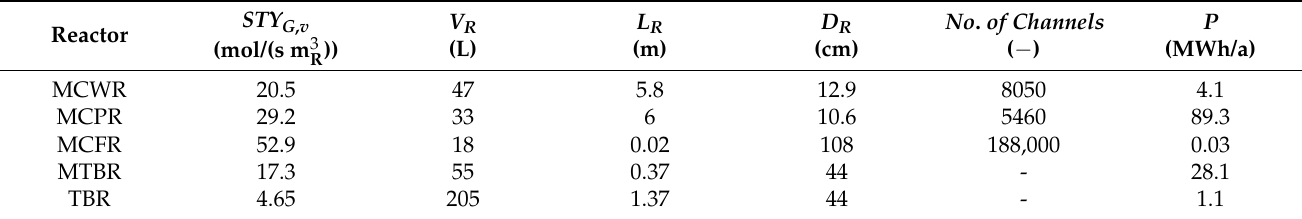
Table 4. Characteristic parameters of the different reactor configurations for the case production scenario of 5000 tonnes/year galactitol (reactors operate at maximal space-time